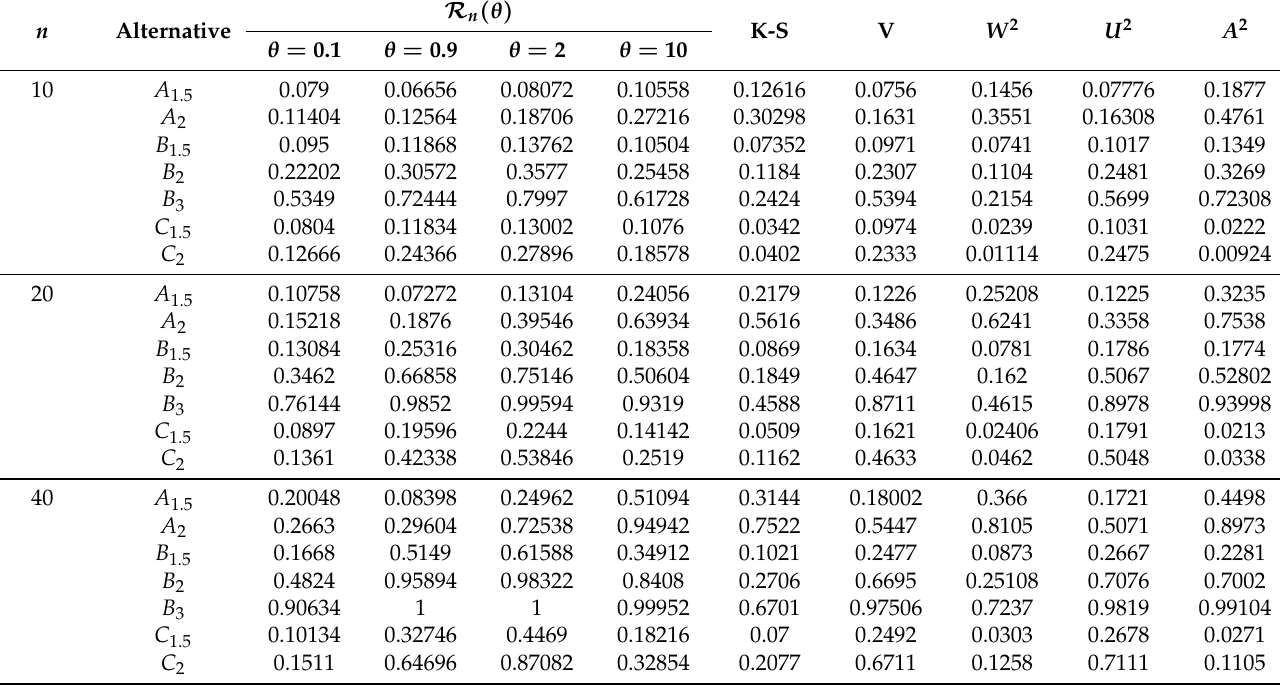
Table 2. Power estimates of the tests at the level α =